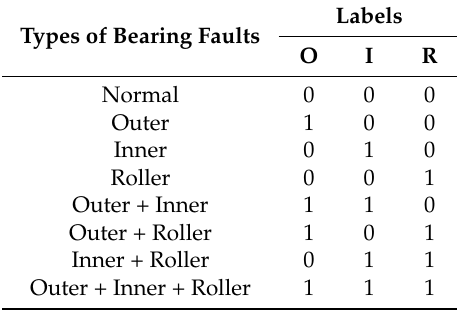
Types of Bearing